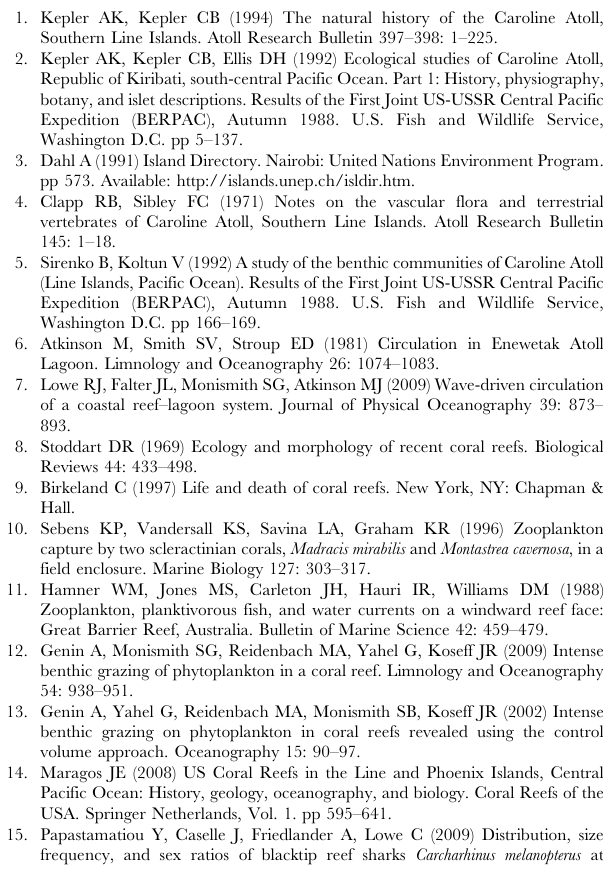
Figure S1 1883 Map of Millennium Atoll (then Caroline Atoll) from the U.S. Coast and Geodetic Survey Report in 1888.